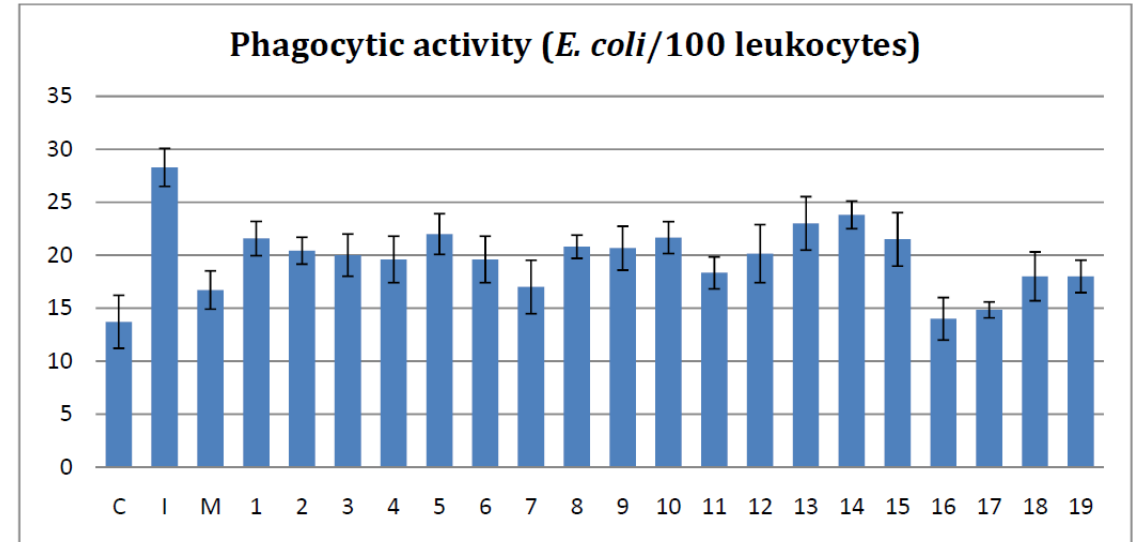
C = negative control; I = inflammation; M =